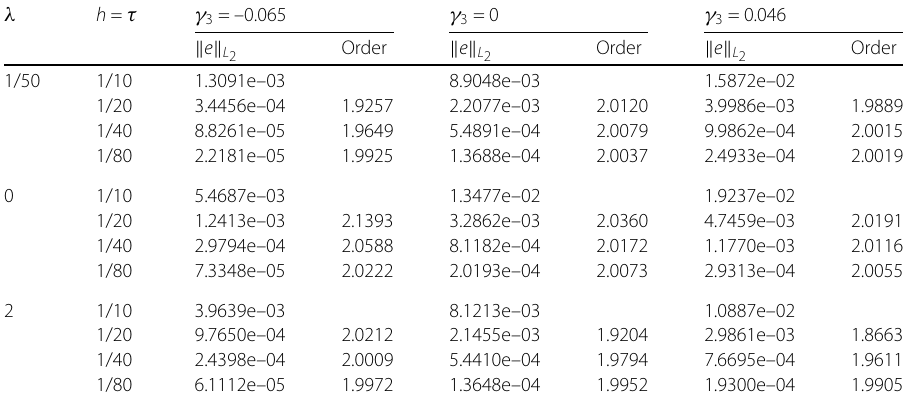
Table 1 Errors and corresponding observation orders at t = 1, α = 1.2